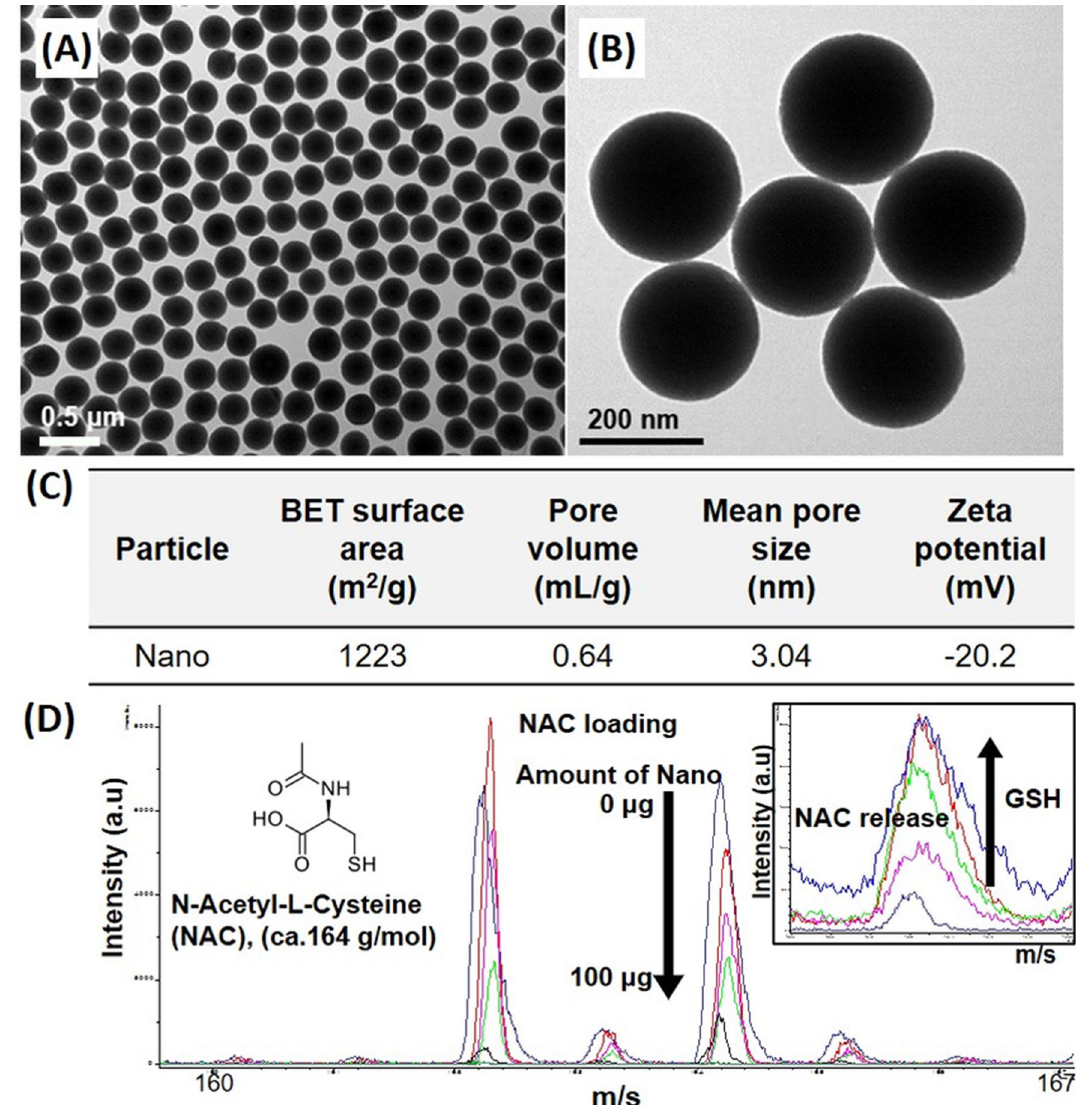
Figure 1. Characterization of the Nano developed in this study. ( A , B ) Transmission electron microscope images of Nano. The images showed that the Nano had a monodispersed morphology with a diameter of approximately 200 nm. ( C ) Nitrogen absorption/desorption analysis was performed to analyze the Brunauer– Emmett–Teller surface area, pore volume, and mean pore size of the Nano. Based on the result of the nitrogen sorption and zeta potential analysis, the prepared Nano possessed a pore size of ~ 3 nm with a cavity and a negative surface charge (-20.2 mV), which was sufficient to load NAC inside the pore. ( D ) Mass spectrometry analysis of the NAC loading and release profile. To investigate the controlled release of NAC under reducing conditions, we measured the NAC-release profiles in the presence of various GSH concentrations (0–10 mM) by mass spectrometry. The results showed that 75% of NAC was released within 1 h, confirming the GSH- dependent release kinetics of NAC from Nano/NAC. Nano Nanoconstruct, NAC N-acetylcysteine, GSH Reduced